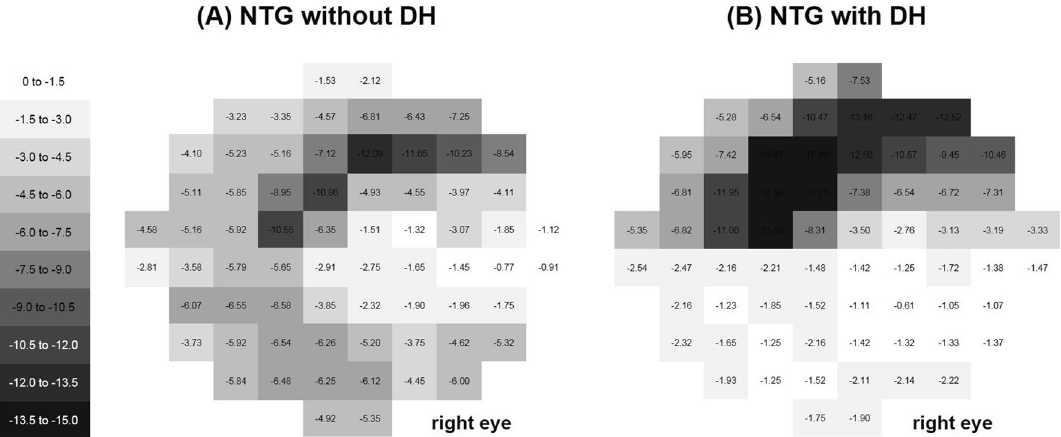
Figure 3. Cross-sectional analysis of the initial paracentral scotoma on 10-2 visual tests (VF) according to the presence or absence of disc hemorrhage. Numerical values of the first 10-2 VF test on the total deviation map were averaged for each VF test location, generating one average map for each subgroup at initial presentation. A linear grayscale was generated and applied to all maps. A and B. Normal-tension glaucoma with